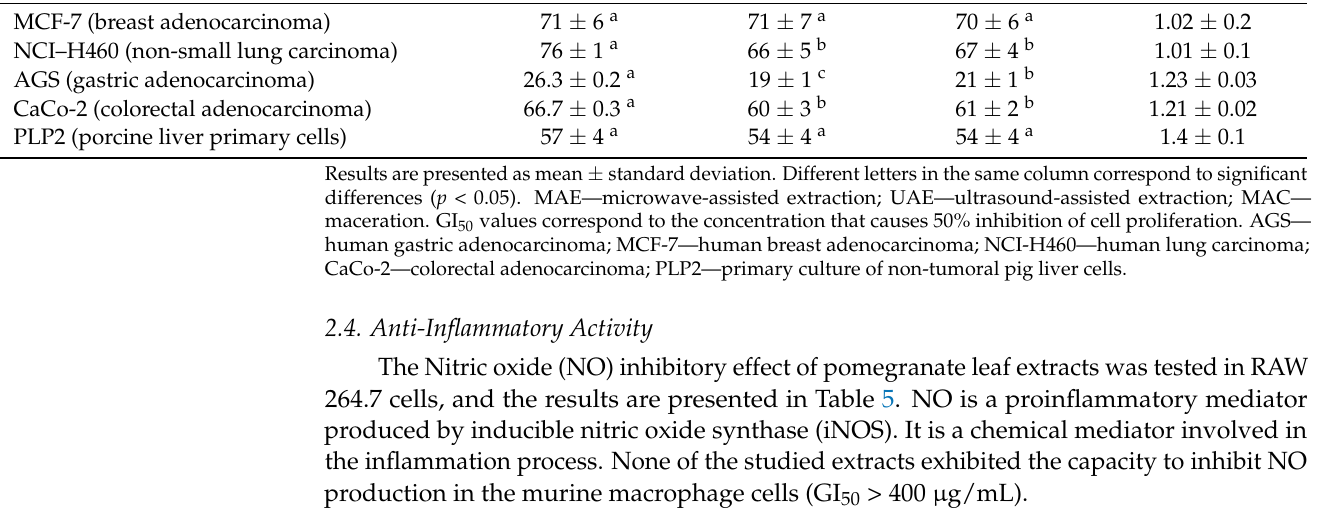
Table 4. Cytotoxic and hepatotoxic properties of P. granatum leaf hydroethanolic extracts. Cytotoxic Activity (GI 50 Values, µ g/mL) MAE UAE MAC Ellipticine